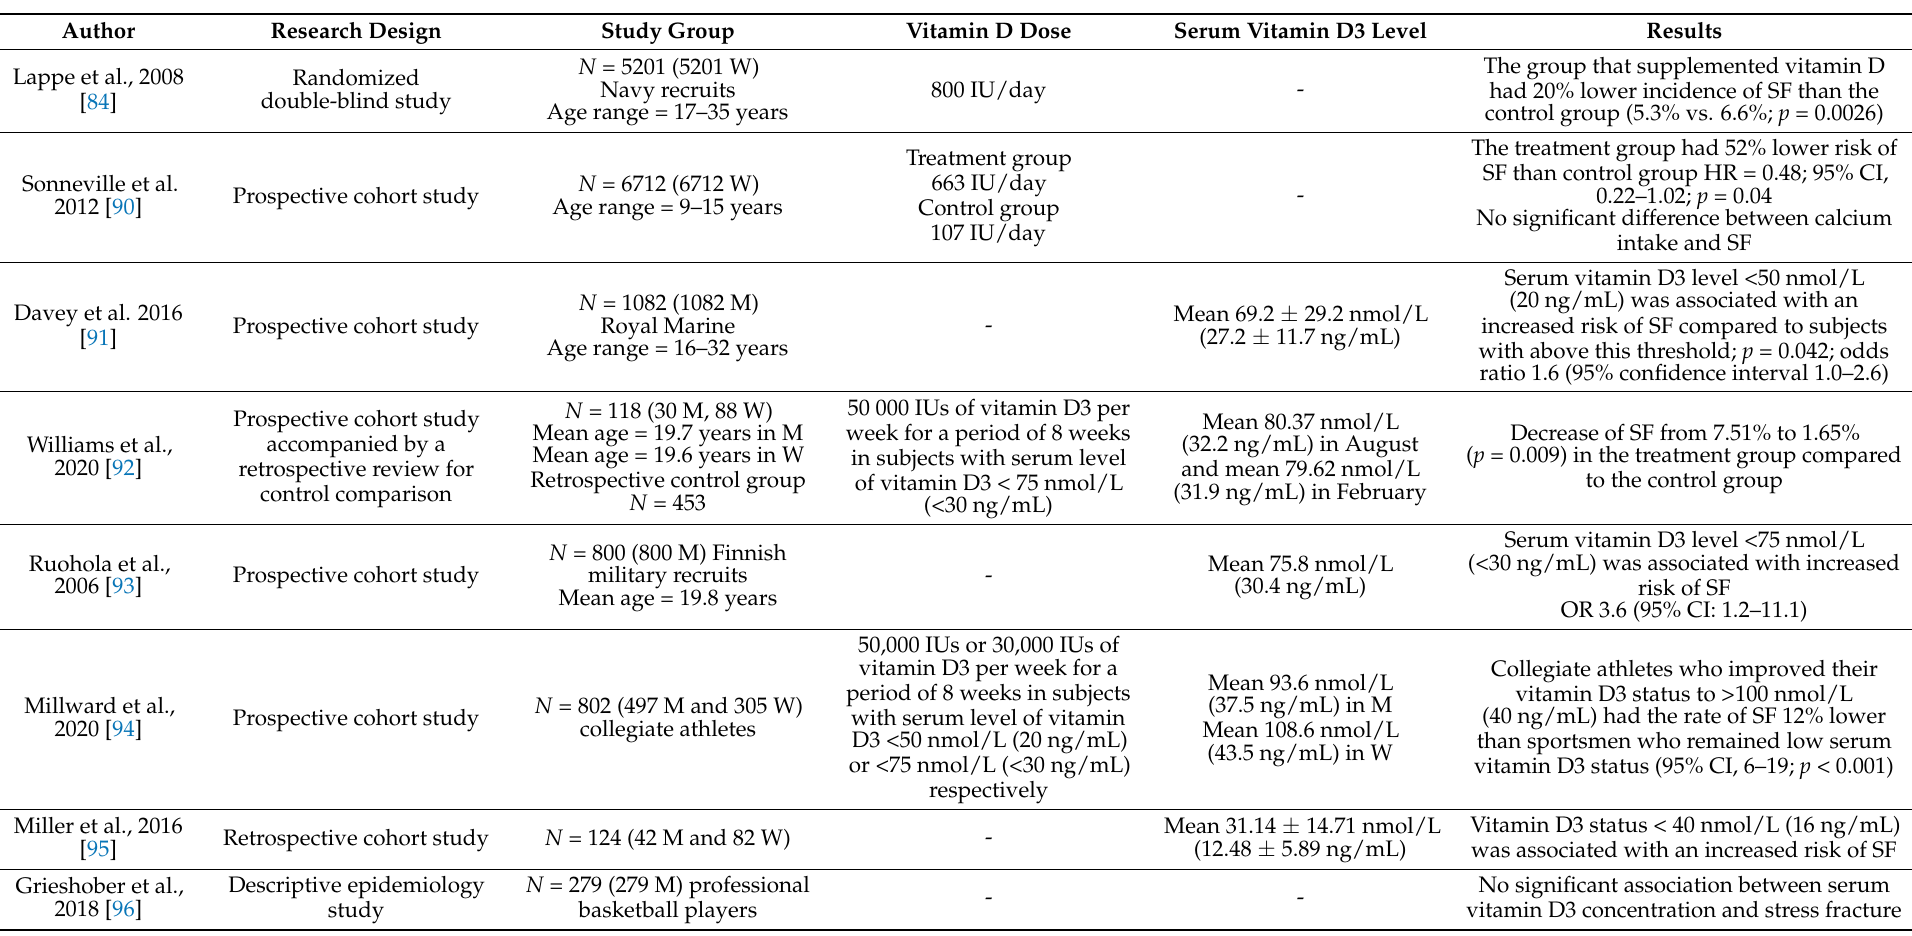
Table 4. Vitamin D supplementation and stress